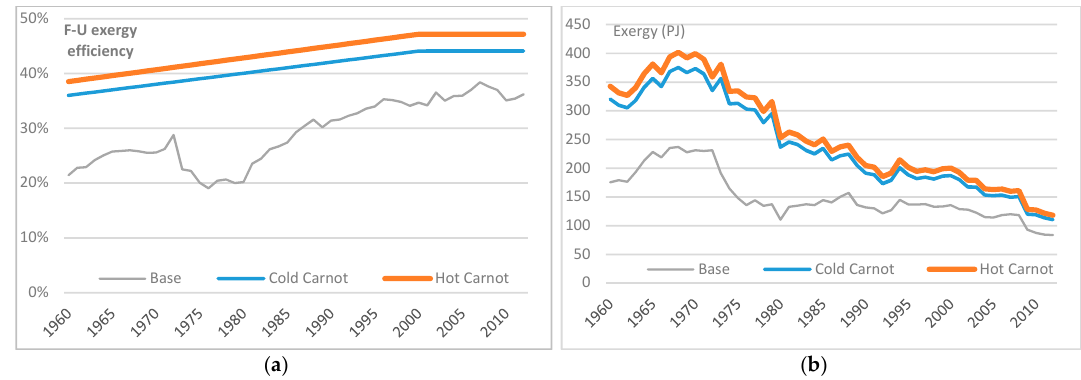
Figure 9. High-temperature industrial heat ( a ) end-use exergy efficiency and ( b ) useful exergy. For the MTH end-use, results are sensitive both to the choice of method and the process